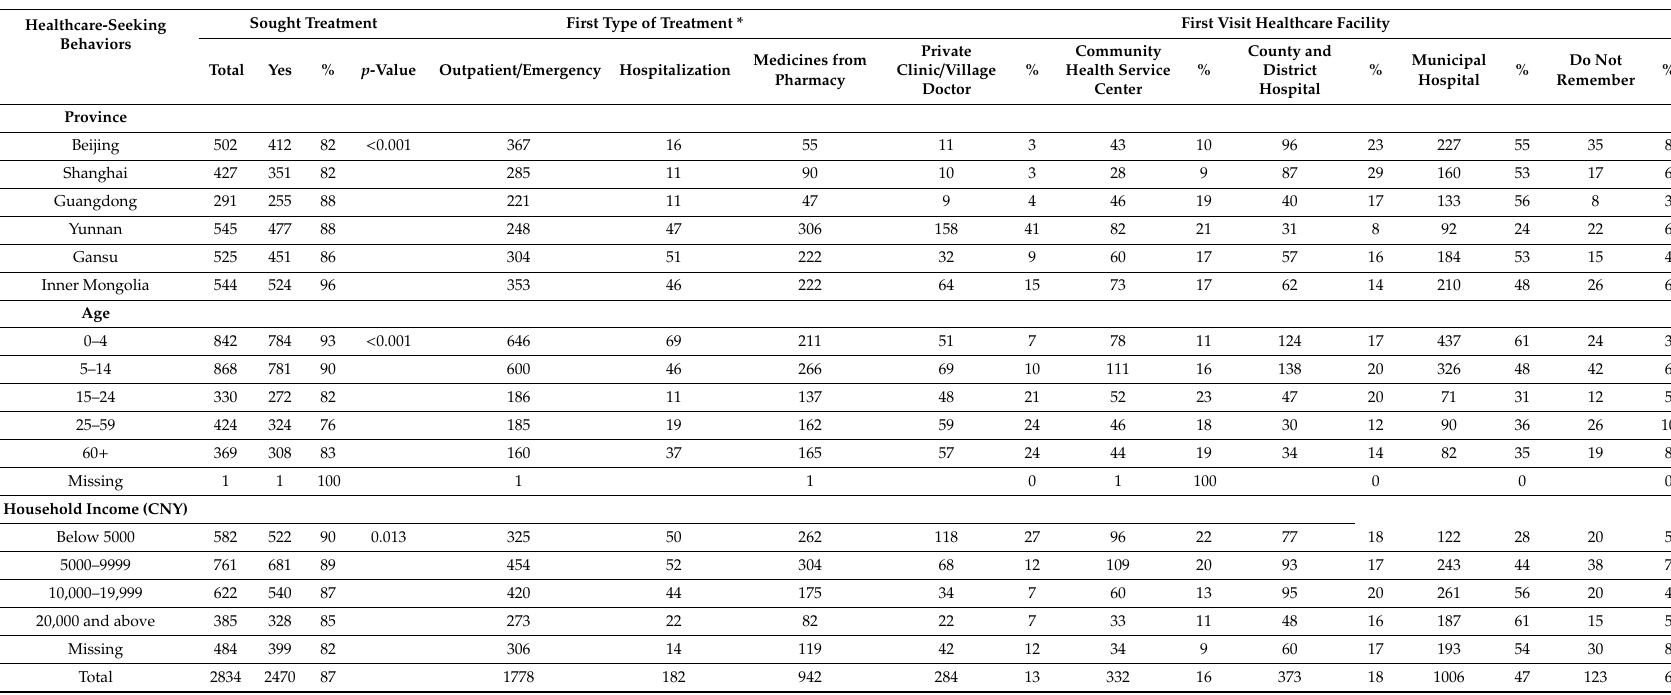
Table 3. Healthcare-seeking behaviors of individuals targeted in a telephone survey in six provinces of China, October 2017 to March 2018. Healthcare-Seeking